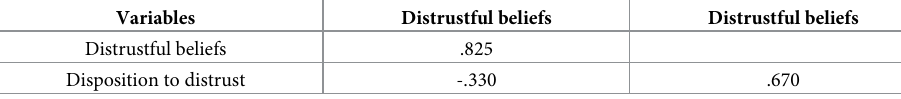
Table 14. Variables intercorrelations between distrust components.